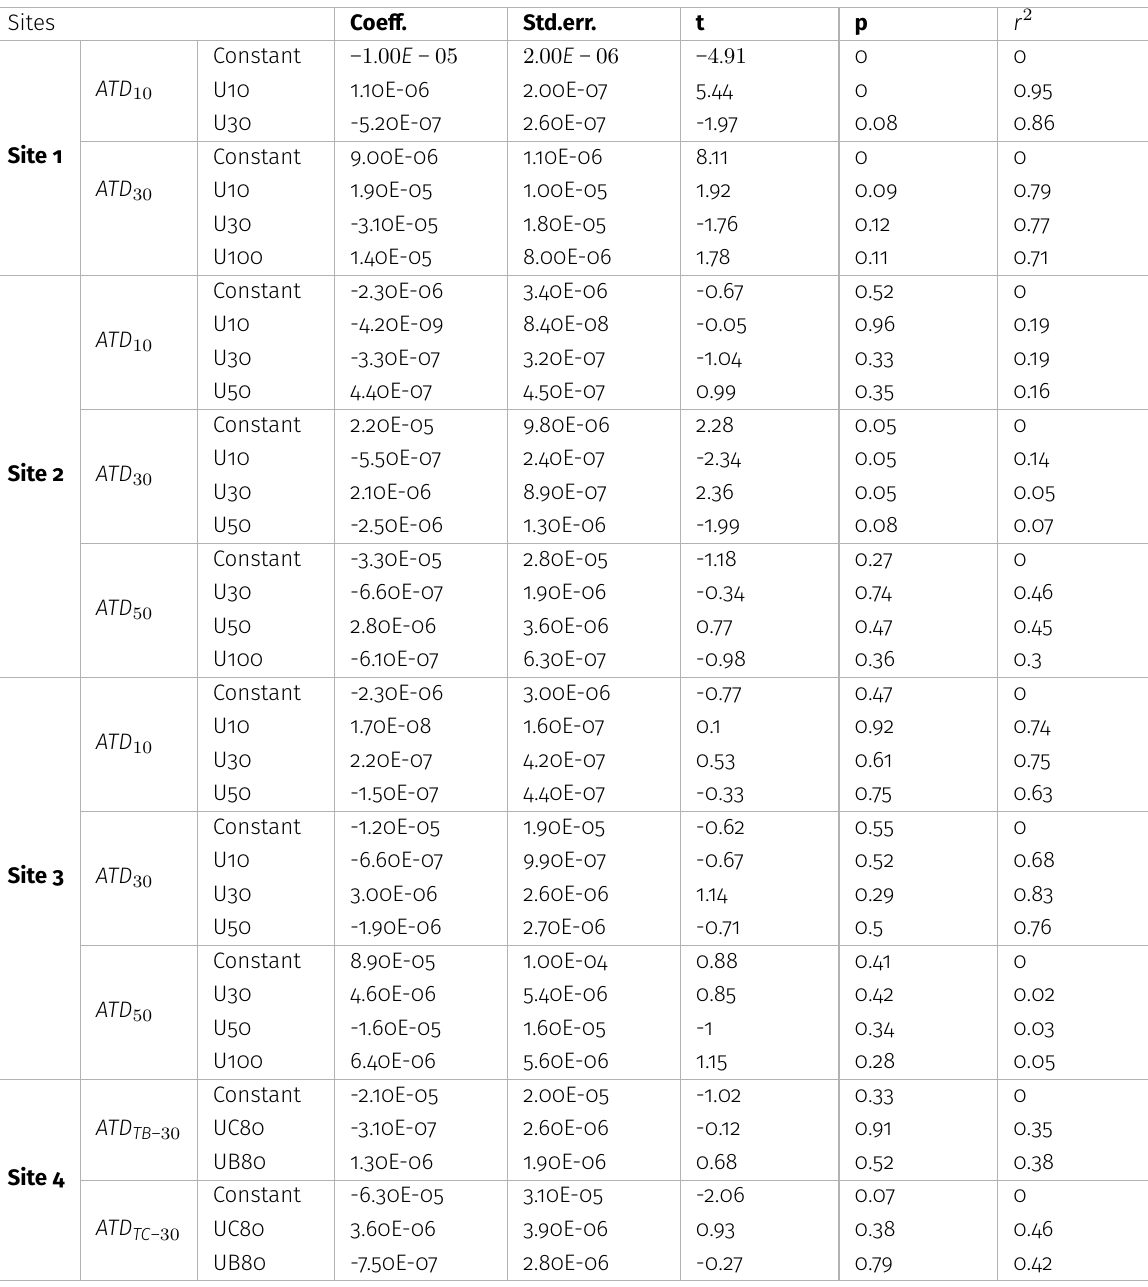
Table IV. Multivariate linear regression between the apparent thermal diffusivity of soil ( ATDATDATD ) and soil moisture ( UUU ) in Keller Peninsula, Maritime